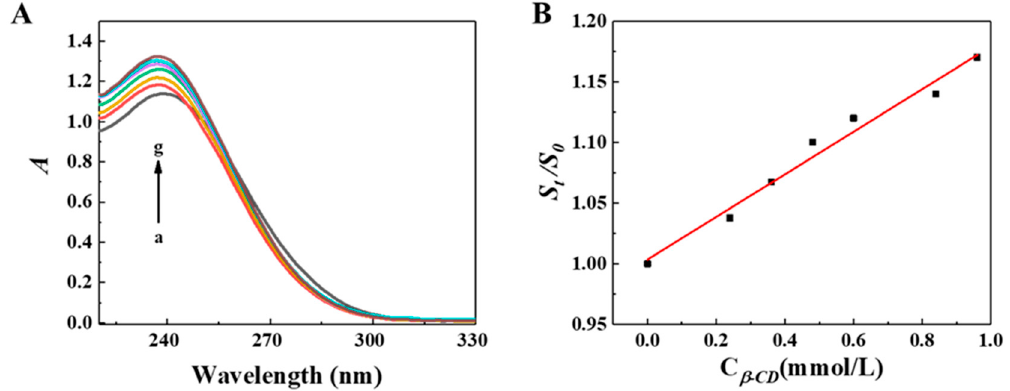
Figure 9. ( A ) UV-vis spectra of excess DPG aqueous solution and β -CDP with different concentrations ( C β -CD : β -CD unit in β -CDP, mmol/L): 0, 0.43, 0.57, 0.86, 1.14, 1.71, 2.56, 3.42 and 4.28. ( B ) Dissolution curve of DPG in the β -CDP aqueous solution.